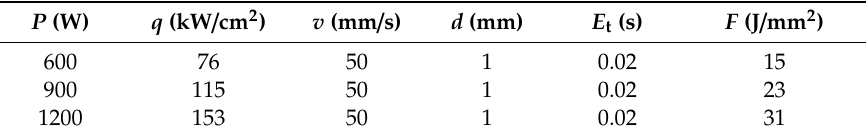
Table 2. Parameters of the laser heat treatment process.